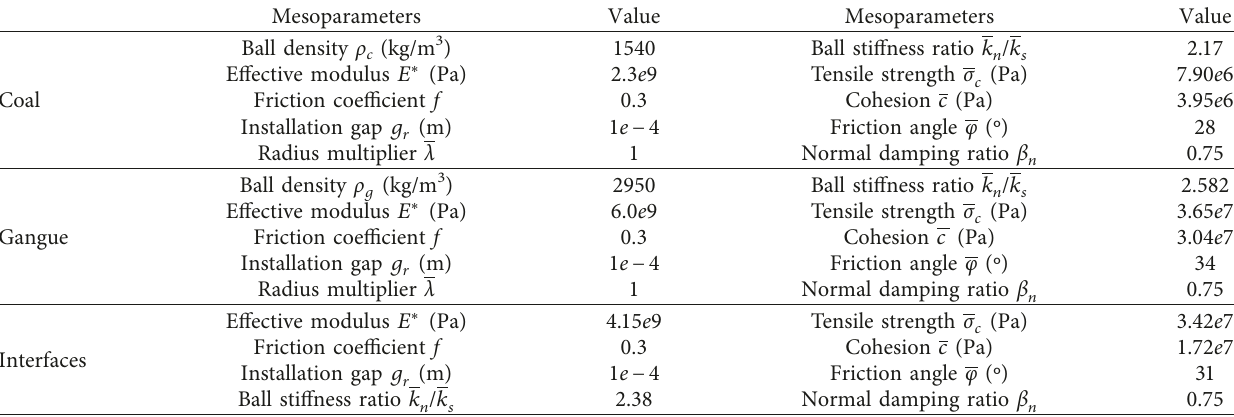
Table 3: Mesoparameters of the PBM used in the DE model.